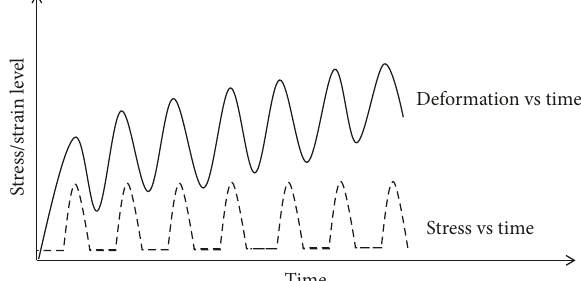
Figure 2: Typical shape of applied repeated load cycles and the generated deformation